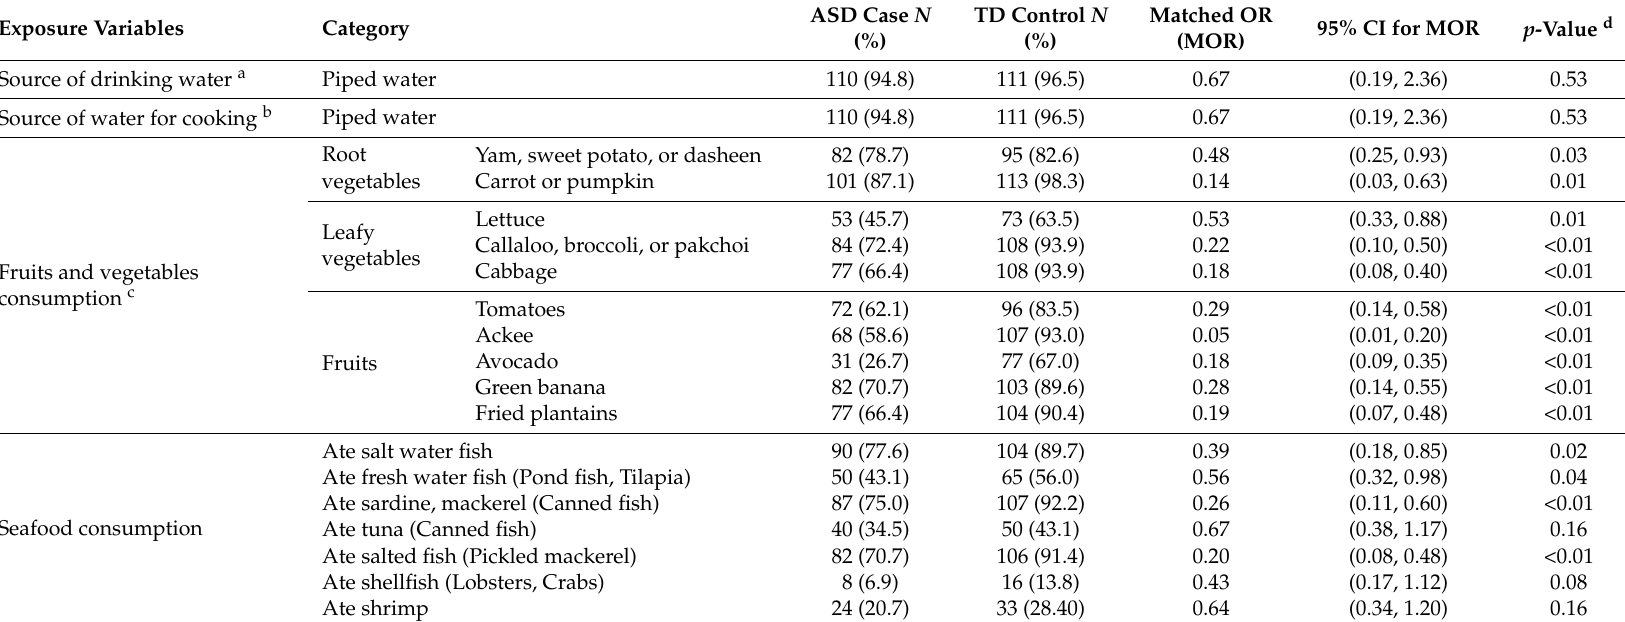
Table 2. Associations between dietary consumption and ASD case status using Conditional Logistic Regression (CLR) (232 children or 116 matched pairs). Exposure